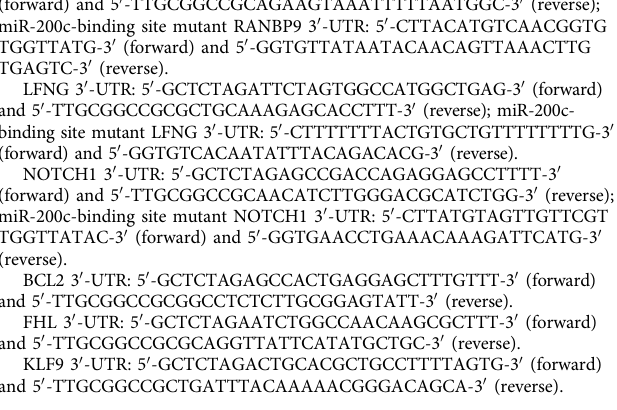
(5313s; clone D10A4), E-cadherin (3195s; clone 24E10), Vimentin (5741s; clone D21H3), Tubulin (2125s; clone 11H10), pERBB3 (2842s; clone D1B5) and ERBB3 (12708s; clone D22C5) were purchased from Cell Signaling and used at a 1:3,000 dilution for western blotting. Goat polyclonal anti-Actin (sc-1616) was purchased from Santa Cruz and used at a 1:1,000 dilution for western blotting. Rabbit polyclonal anti-NOTCH1 (ab27526) was purchased from Abcam and used at a 1:3,000 dilution for western blotting. Mouse monoclonal anti-FLAG (F1804; monoclonal; clone M2) was purchased from Sigma and used at a 1:5,000 dilution for western blotting. siRNAs were purchased from Santa Cruz (pooled siRNAs) or Origene (individual siRNAs for ZEB1 and RBPJ). All short hairpin RNAs and chemicals were purchased from Sigma, except for BMS-708163 and gefitinib, which were purchased from Selleckchem. Control GFP (LPP-EGFP-LV105-025) and ZEB1 lentiviral particles (LPP-F0876-Lv105-200-S) were purchased from Genecopoiea. Cell culture and transfection . Mycoplasma-free and authenticated (short tandem repeat (STR) profiling) human lung epithelial cell line BEAS2B and lung adenocarcinoma cell line HCC4006 were purchased from American Type Culture Collection. All other lung adenocarcinoma cell lines (including HCC827, H3255, H1975, H2279, H322. 393P, H441 and H1299 cells) were gifts from Jonathan Kurie M.D. (MD Anderson Cancer Center). All cells were cultured in RPMI-1640 (Mediatech) supplemented with 10% fetal bovine serum (Life Technologies). Lipofectamine 2000 and RNAiMAX (both from Life Technologies) were used for transfection of DNA or RNA, respectively. For stable transfection, antibiotic selection was introduced at 48h after transfection. To generate gefitinib-resistant sublines (HCC827GR and HCC4006GR), HCC827 and HCC4006 cells were continuously treated with 1 m M gefitinib for 10–12 weeks. DNA sequencing . Genomic DNA was extracted using the QIAamp DNA Mini Kit (Qiagen). Genomic exons 18–21 of the EGFR gene and exons 2–4 of the K-RAS gene were separately amplified using AmpliTaq Gold 360 PCR Master Mix (Life Tech- nologies). The PCR was performed with a denaturing step at 95 (cid:2) C for 5min, then 30s at 95 (cid:2) C, 30s at 56 (cid:2) C and 30s at 72 (cid:2) C for 35 cycles, followed by a final 7min at 72 (cid:2) C. The PCR products were visualized on a 1% agarose gel and then subjected to direct sequencing within Mayo Clinic Molecular Biology core. The following sequencing primers were used: EGFR exon 18: 5 0 -CTGAGGTGACCCTTGTCTCTG-3 0 EGFR exon 19: 5 0 -TGCCAGTTAA- CGTCTTCCTT-3 0 EGFR exon 20: 5 0 -CATTCATGCGTCTTCACCTG-3 0 EGFR exon 21: 5 0 -TGATCTGTCCCTCA CAGCAG-3 0 EGFR T790M: 5 0 -CTCCAGGAAGCCTACGTGAT-3 0 KRAS exon 2: 5 0 -AAGGCCTGCTGAAAATGACTG-3 0 KRAS exon 3: 5 0 -GCACTGTAATAA TCCAGACT-3 0 KRAS exon 4: 5 0 -GACAAAAGTTGTGGACAGGT-3 0 . Constructs . 3 (cid:3) FlagNICD1 (plasmid #20183, a gift from Raphael Kopan, Cincin- nati Children’s Hospital 50 ) and ErbB-3-pGL3 (plasmid #60899, a gift from Frederick Domann, The University of Iowa 51 ) were from Addgene. Mouse ZEB1 complementary DNA was cloned into pcDNA3.1 vector (cloning primers: 5 0 -TCG AATTCATGGCGGATGGCCCCAGGTGTAA-3 0 and 5 0 -GAGCGGCCGCCTAA GCTTCATTTGTCTTCTCTT-3 0 ). Full-length 3 0 -UTRs of TOB1, RANBP9, LFNG, NOTCH1, BCL2, FHL and KLF9 were cloned from the HCC827-ZEB1 cells by PCR and inserted into the pCI-hRL vector. The Q5 Site-Directed Mutagenesis Kit (NEB) was used to generate mutant constructs. The following primers were used to clone the wild-type or mutant 3 0 -UTR constructs for the above genes: TOB1 3 0 -UTR: 5 0 -GCTCTAGATTCTAACCAGCAATTCCAGC-3 0 (forward) and 5 0 -TTGCGGCCGCAACTATTTCAGTCCCTCTT-3 0 (reverse); miR-200c-